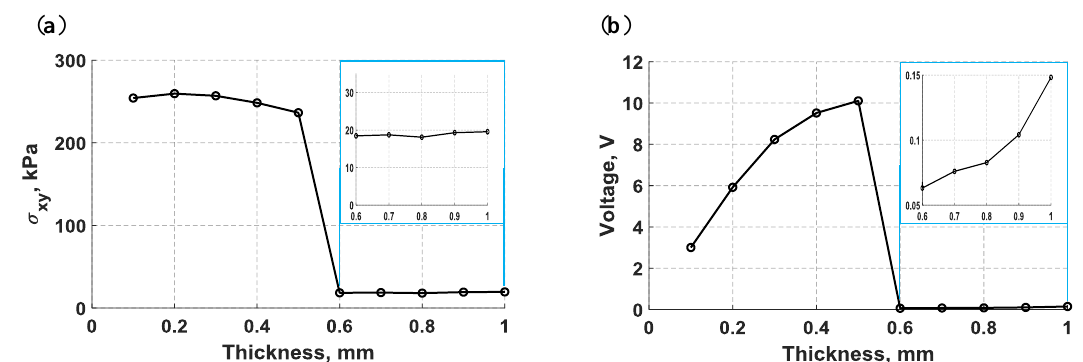
Figure 11. A numerical parametric study varying the thickness of bondline embedded d35 PZT transducers and actuating with a 5-peak tone burst signal at 30 kHz; ( a ) maximum in-plane shear-stress generated by the d35 PZT actuator, and ( b ) maximum voltage produced by the d35 PZT sensor.